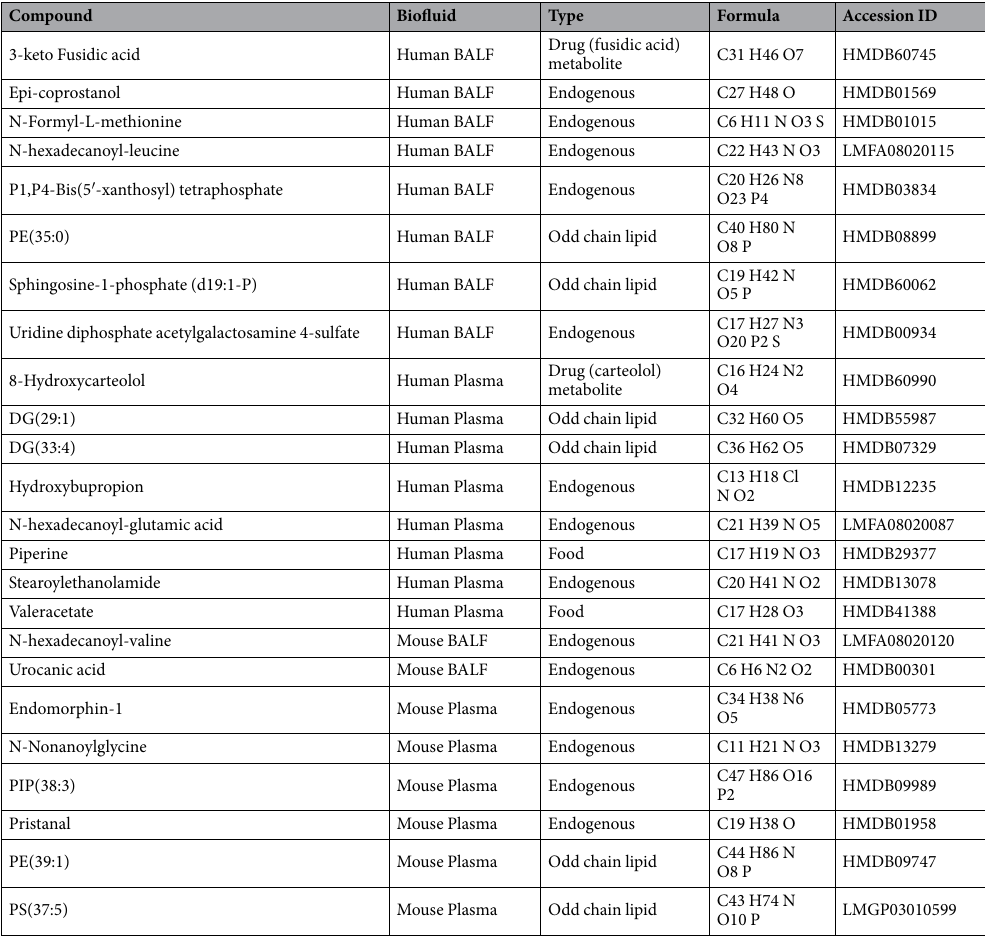
Table 2. Representative unique metabolites to mouse and human BALF and plasma. This list contains randomly selected metabolites that were annotated using an in-house database comprised of METLIN, HMDB, Lipid Maps and KEGG. Metabolites were selected randomly. Scores ≥ 70 out of a possible 100 and mass errors ≤ 10 ppm were used for annotation thresholds. Annotations were based on exact mass and isotope ratios. DG: diglyceride, PE: phosphatidylethanolamine, PIP: phosphatidylinositol phosphate, PS: